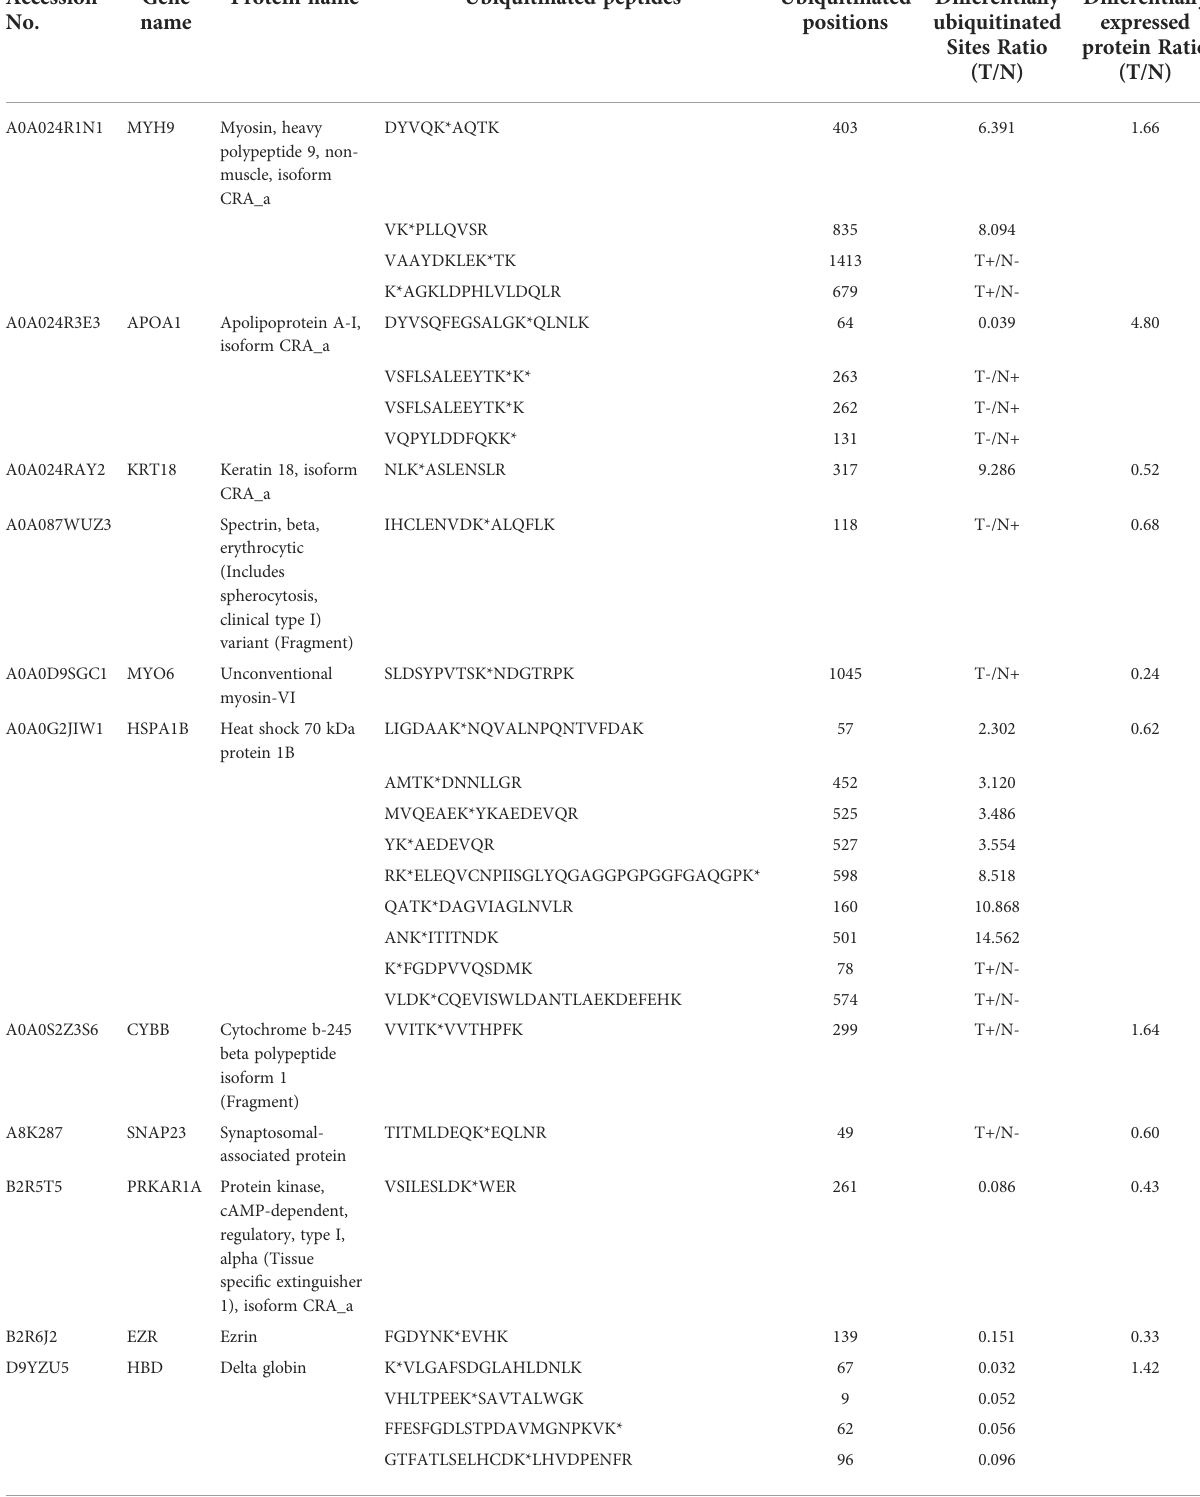
TABLE 1 Differentially expressed proteins with signi fi cantly ubiquitination alterations in LSCC tissues compared to controls. Accession